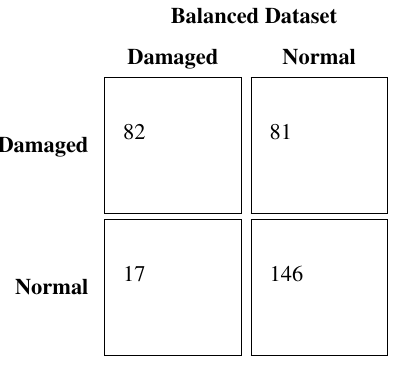
Table 8. Confusion matrix of the Balanced Dataset.